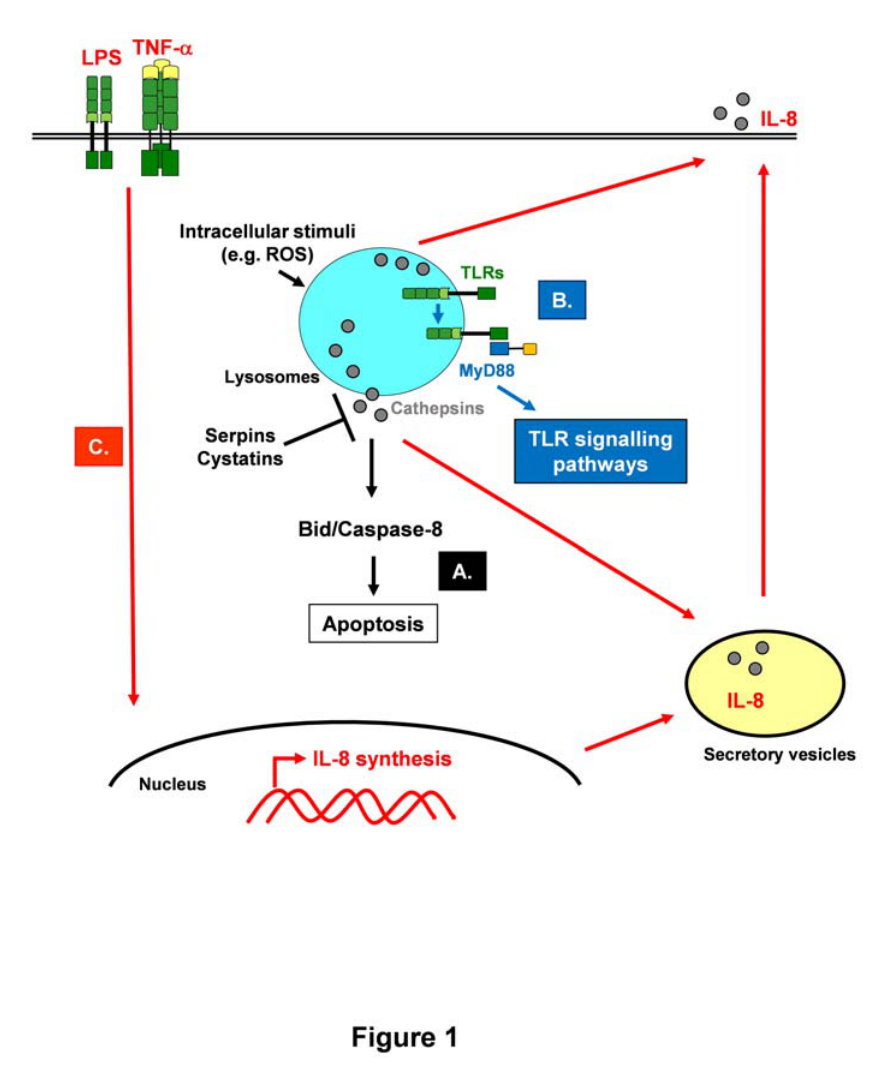
Roles of cathepsins in innate immunity. A. Depending on the cell type and the stimuli, cathepsins are rapidly released into the cytosol where they induce proteolysis of caspase-8 or the Bcl-2 family member Bid, which subsequently activates the enzymatic signalling cascade leading to apoptosis. Cysteine protease inhibitors, like serpins and cystatins, may regulate cathepsin activity in the cytosol. B. Lysosomal cathepsins induce proteolytic cleavage of TLRs (e.g. TLR7 and TLR9), which is a prerequisite for their signalling. The processed form then recruits the adaptor protein MyD88, which will in turn launch the different TLR signalling pathways. C. Inflammatory signals (e.g. LPS or TNF- α) induce the synthesis and secretion of cytokines and chemokines, such as IL-8. The secreted IL-8 precursor is converted into a mature form with enhanced neutrophil chemoattractant properties, by cathepsin